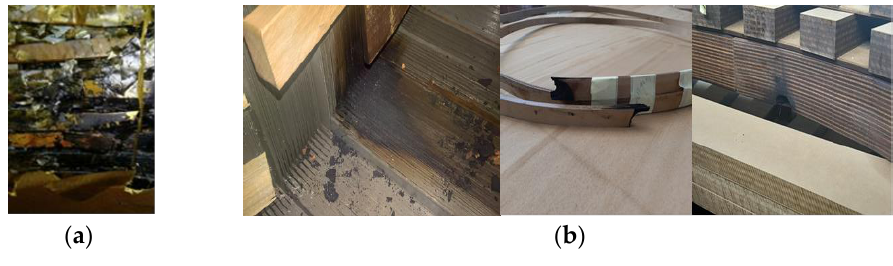
Figure 5. Pictures of fault area: ( a ) — Case 1, ( b ) — Case 2.